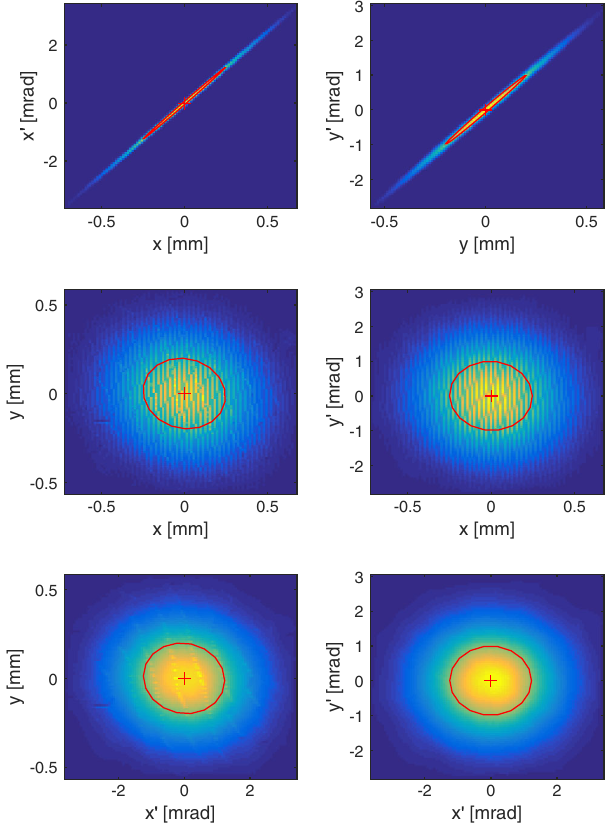
fit from the x 0 ij